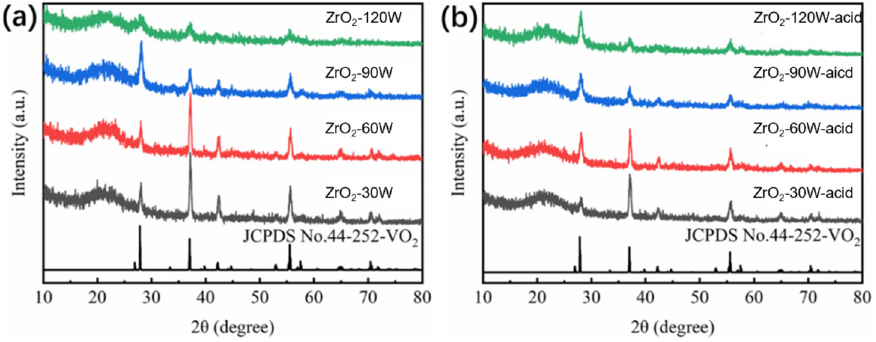
Figure 2. XRD patterns of ( a ) sample ZrO 2 -30 W, ZrO 2 -60 W, ZrO 2 -90 W, and ZrO 2 -120 W and ( b ) sample ZrO 2 -30 W-acid, ZrO 2 -60 W-acid, ZrO 2 -90 W-acid, and ZrO 2 -120 W-acid.